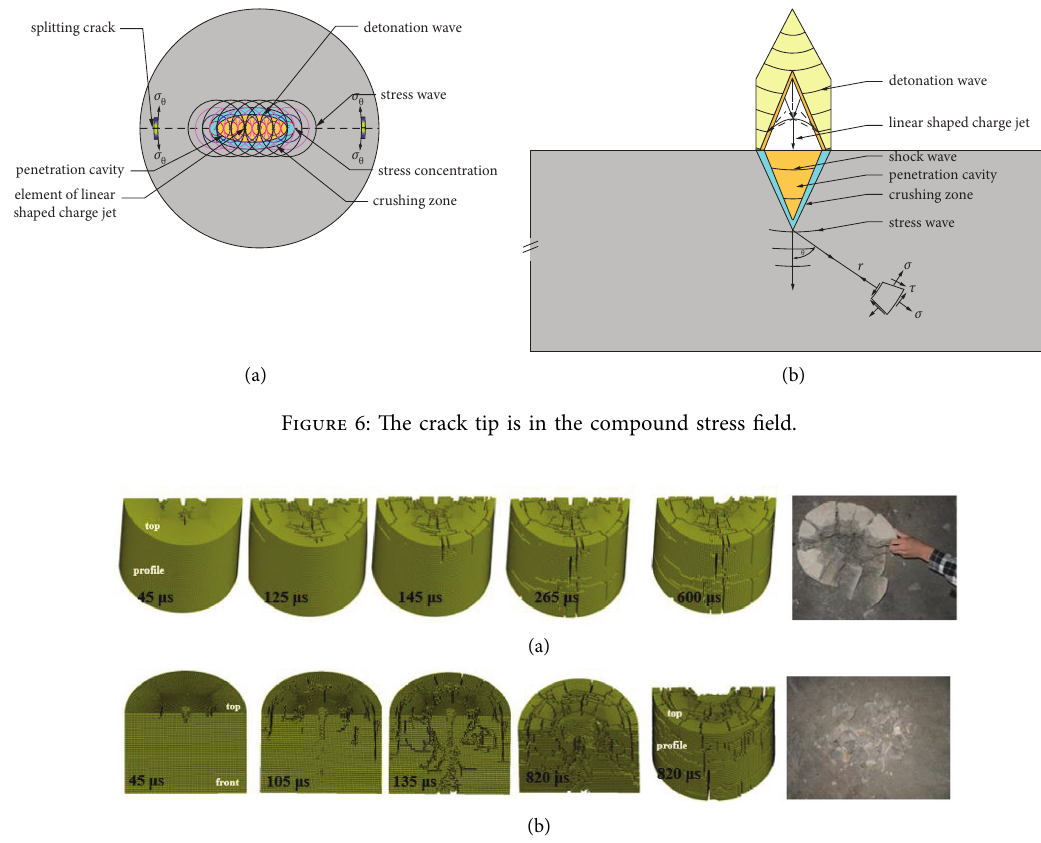
Figure 7: The effect of the shaped charge wedge angle. (a) Case 3. (b) Case